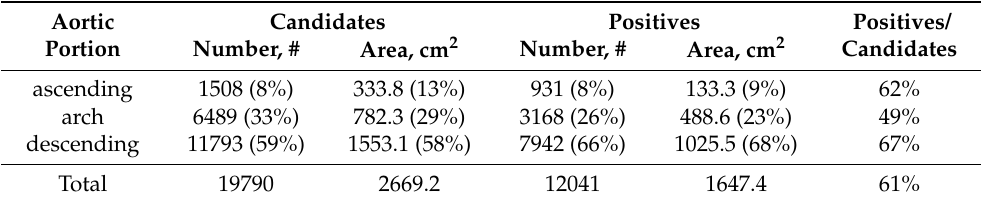
Table 2. Number and total area of candidate lesions and positive calcifications for the three segments of the thoracic